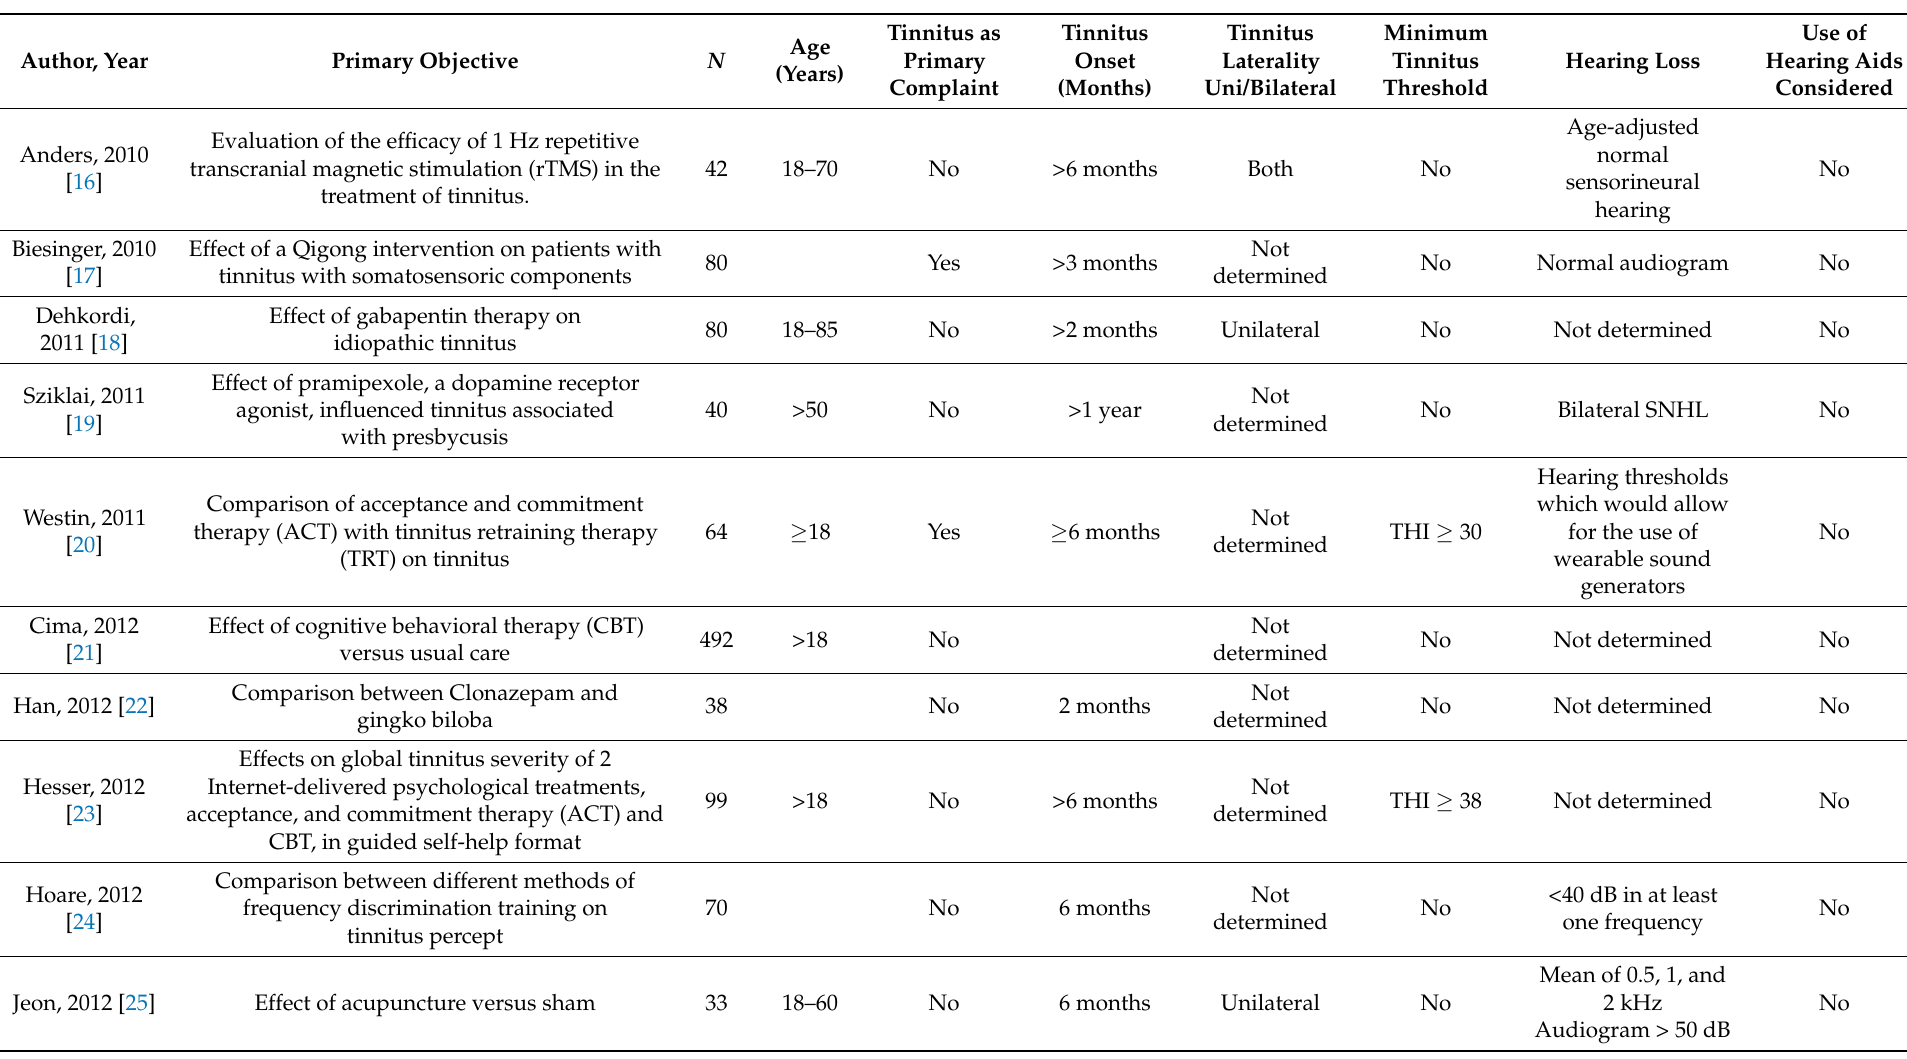
Table 1. Characteristics of included studies: Inclusion